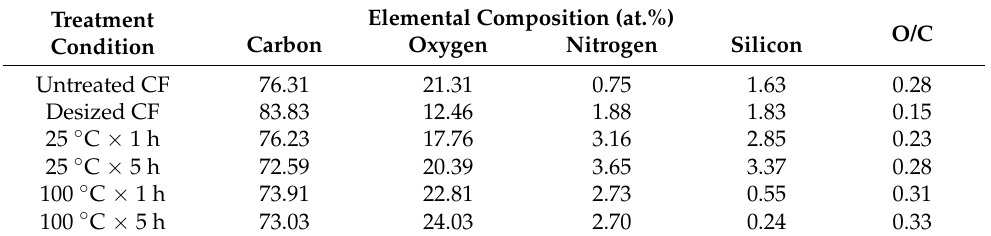
Table 2. Effect of chemical treatment conditions on the surface elemental composition of carbon fibers.